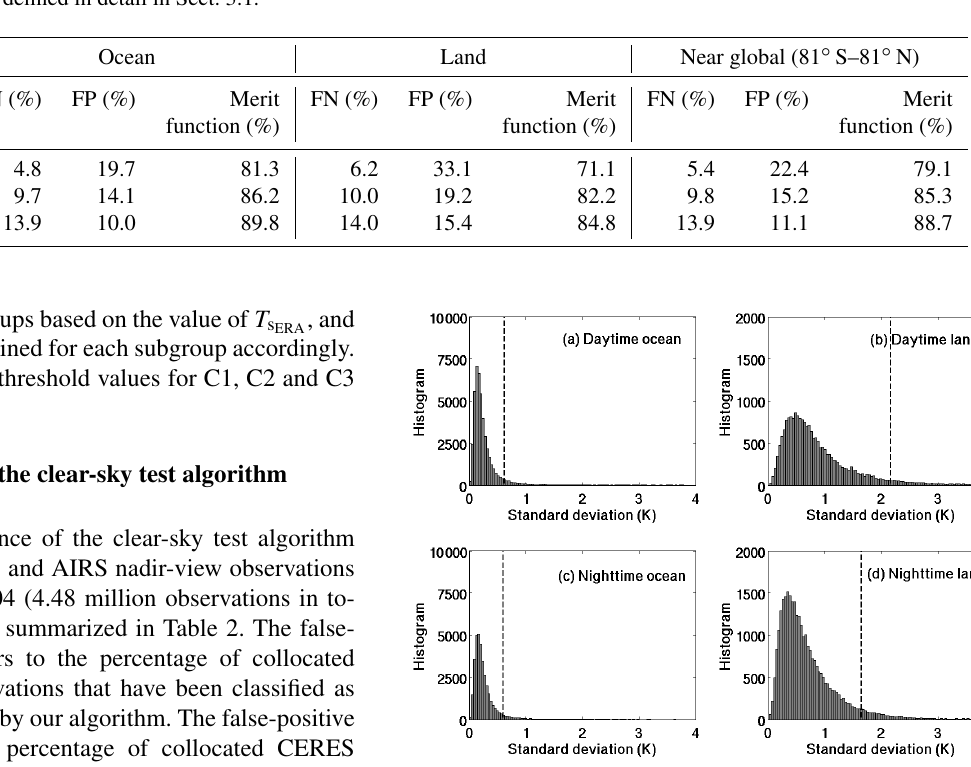
Table 2. The performance of clear-sky detection algorithm. FN (false negative) is the percentage of CERES clear-sky observations misclas- sified as cloudy sky by the algorithm. FP (false positive) is the percentage of CERES cloudy-sky observations misclassified as clear sky by the algorithm. Merit function is the overall success rate compared to the CERES algorithm in terms of distinguishing clear- vs. cloudy-sky observations. Steps 1–3 are defined in detail in Sect. 3.1.